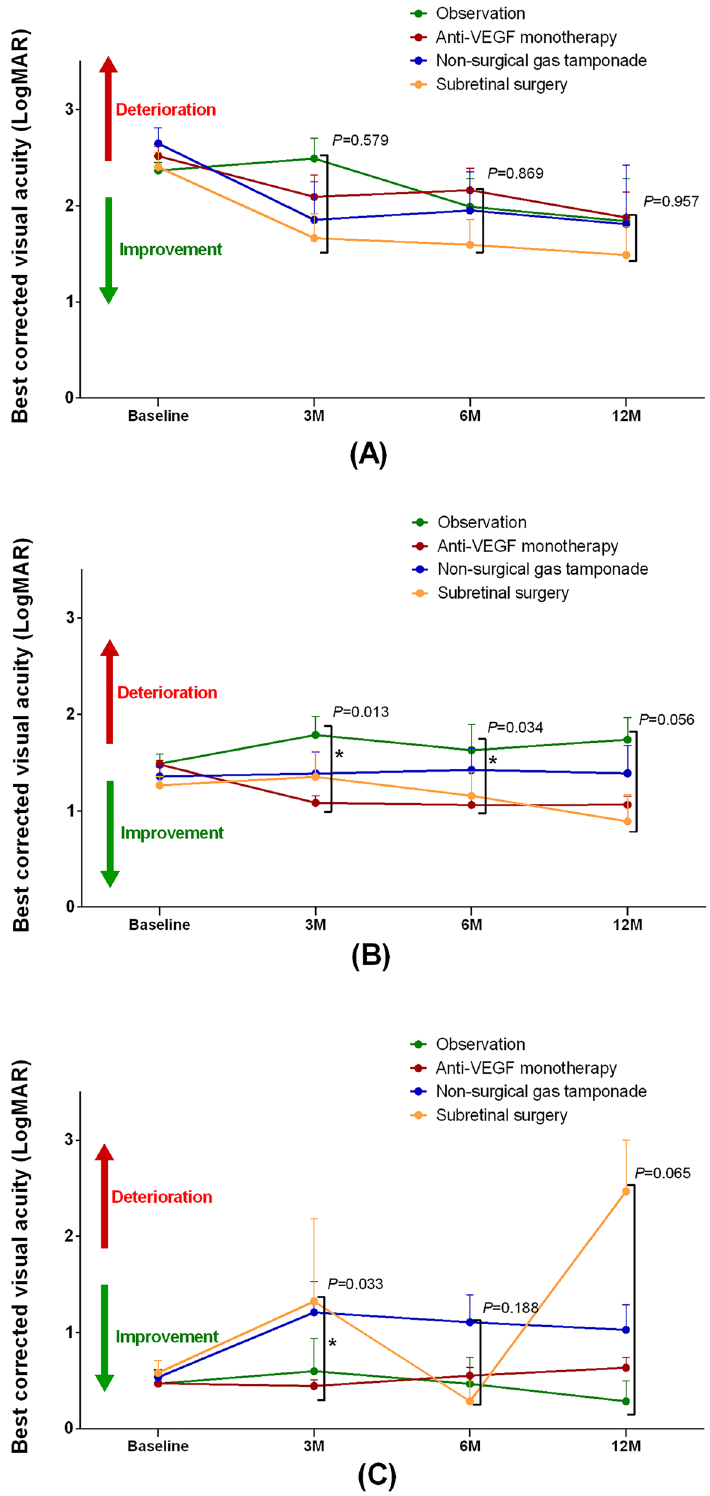
Figure 2. The subgroup anaylsis based on baseline best-corrected visual acuities (BCVA). ( A ) Poor: Baseline BCVA ≥ 2.0 LogMAR (Baseline BCVA ≤ 20/400). ( B ) Intermediate: 1.0 LogMAR ≤ Baseline BCVA < 2.0 LogMAR (20/400 < Baseline BCVA ≤ 20/200). ( C ) Good: Baseline BCVA < 1.0 LogMAR (Baseline BCVA > 20/200). LogMAR, logarithm of the minimum angle of resolution; M,